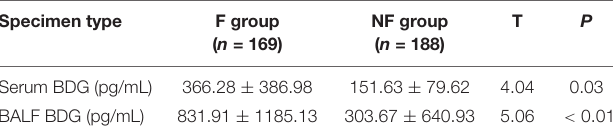
TABLE 2 | Comparison of the serum and BALF BDG levels between groups.